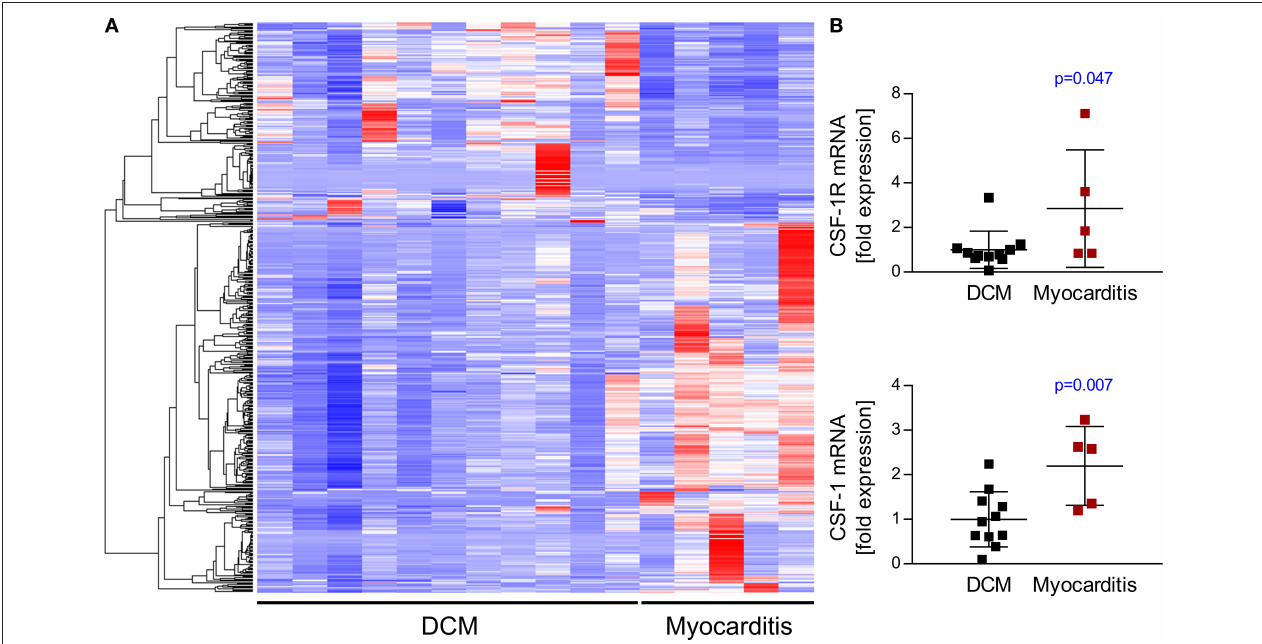
FIGURE 1 | Transcriptome analysis of endomyocardial specimen from patients with dilated cardiomyopathy and myocarditis . RNA-Sequencing data from endomyocardial biopsies obtained from patients with clinically diagnosed myocarditis or dilated cardiomyopathy as a control were analyzed for relative expression of different gene sets. (A) RNA-seq analyses revealed differential expression of 1963 genes. Heatmap depicts top 500 differentially expressed genes hierarchically clustered by using Euclidean distance measures. (B) CSF-1 and CSF-1R expression taken from RNA-seq data. Unpaired t- tests were used; p -values are indicated on the graph and significant differences ( p < 0.05) are marked with blue